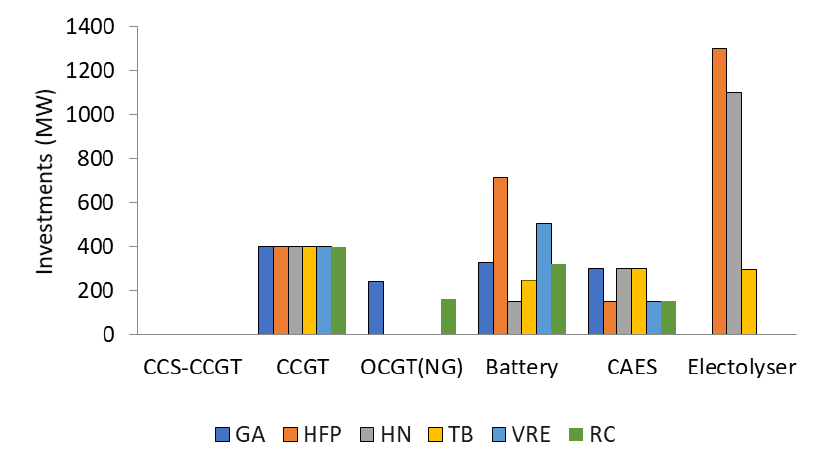
Figure 8. 2030 investments including dispatchable generation capacities and load